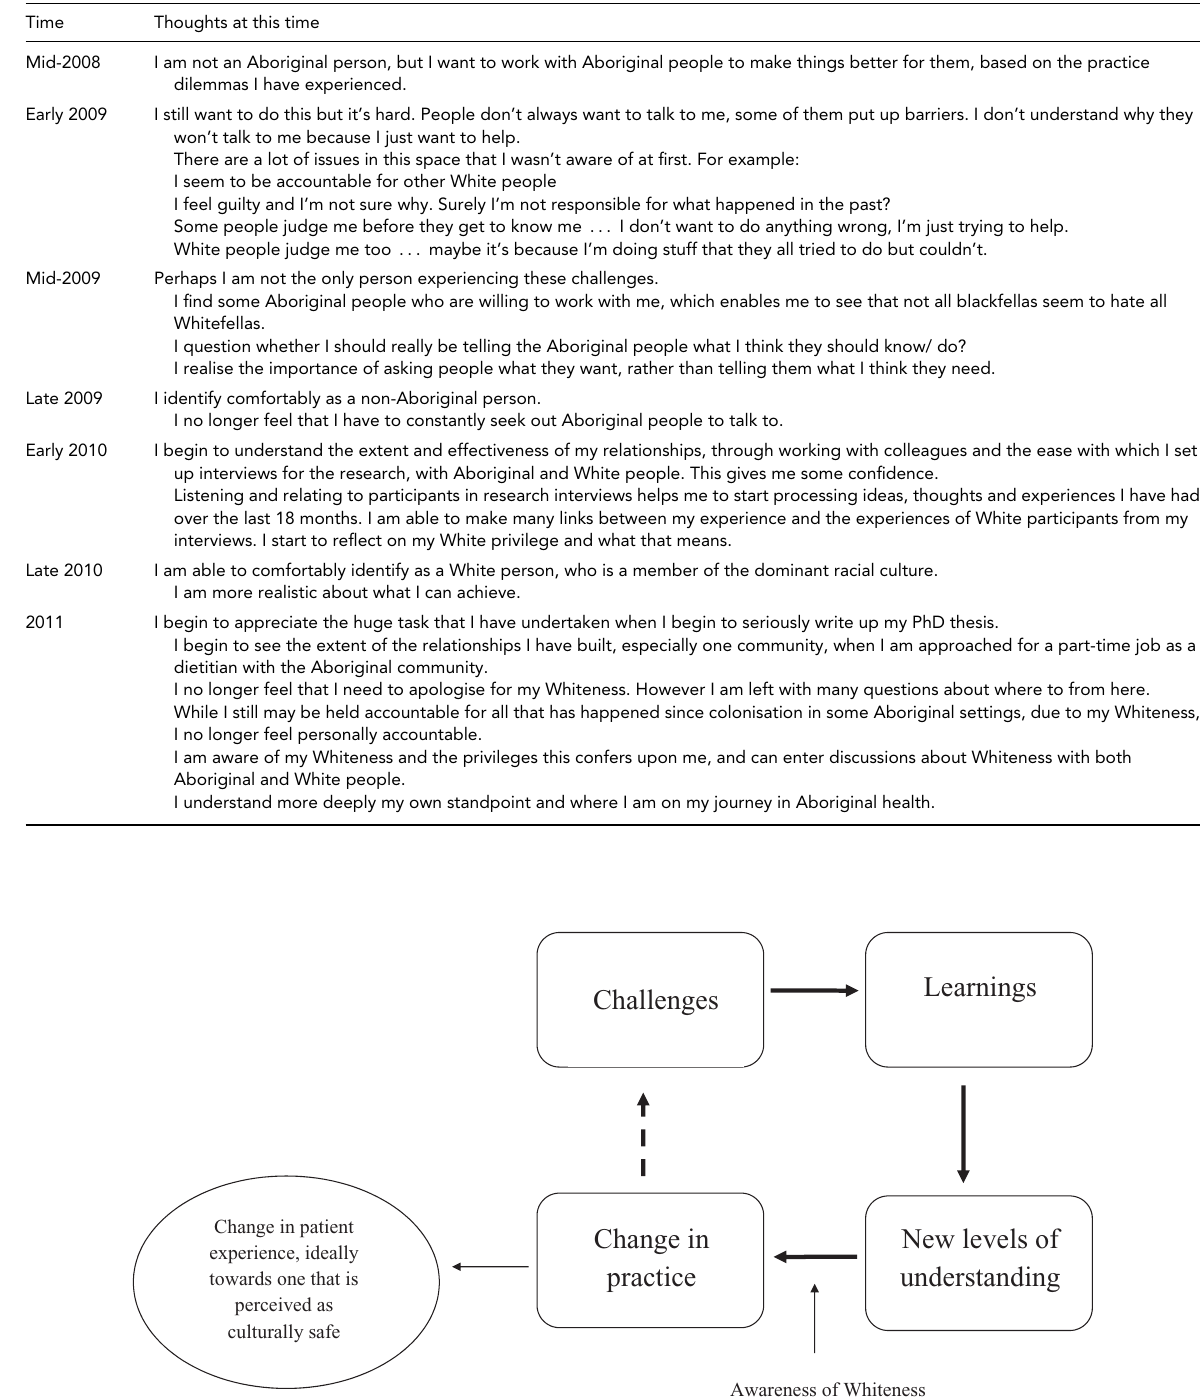
Summary of My Key Thoughts and Experiences About Race and My Whiteness While Doing a PhD in the Area of Aboriginal Health